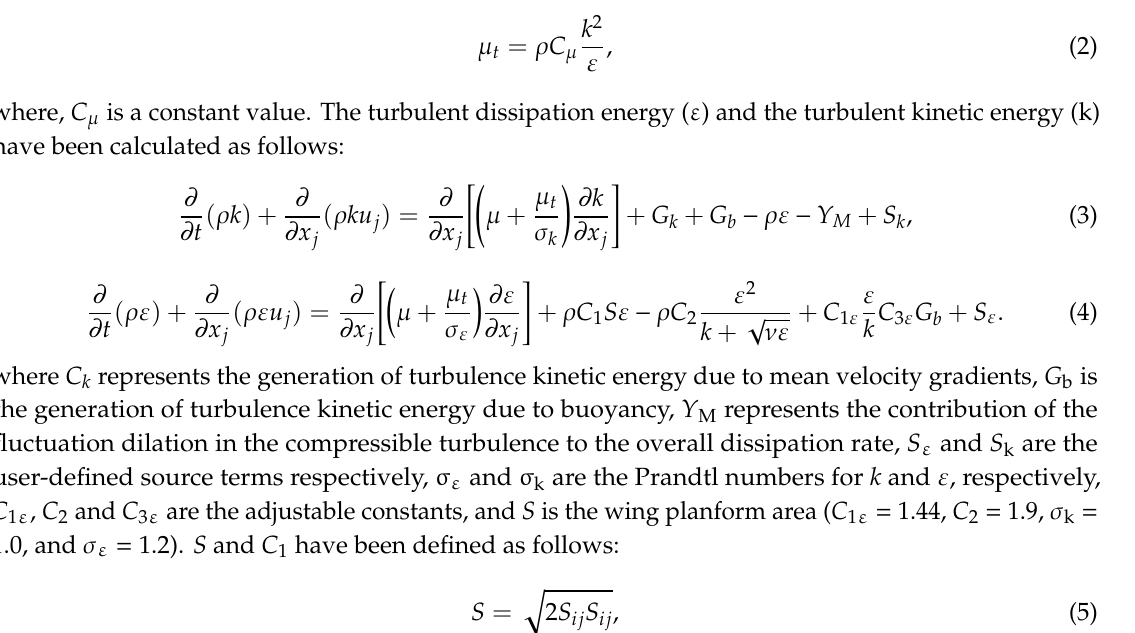
Figure 2. Detailed view of the mesh around a section of the compound wing.